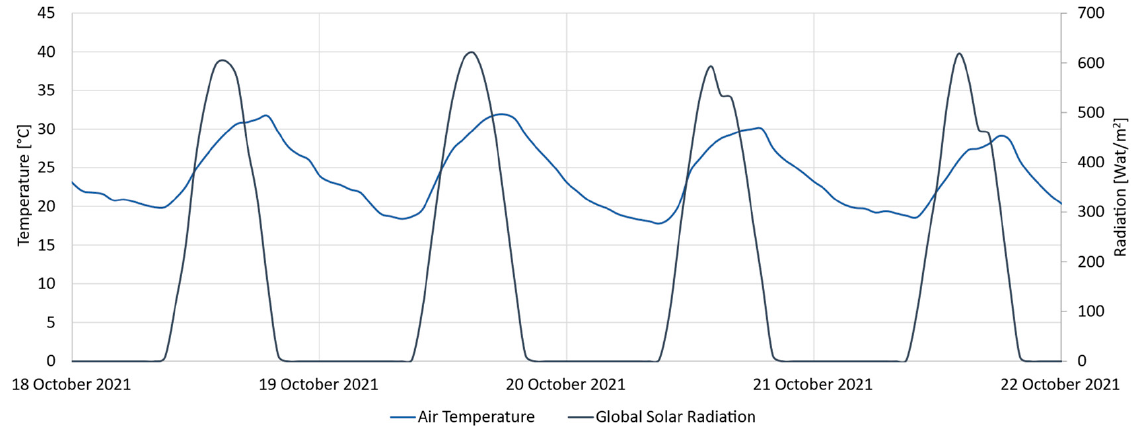
Figure 16. Air temperature and global horizontal radiation on the four selected days.